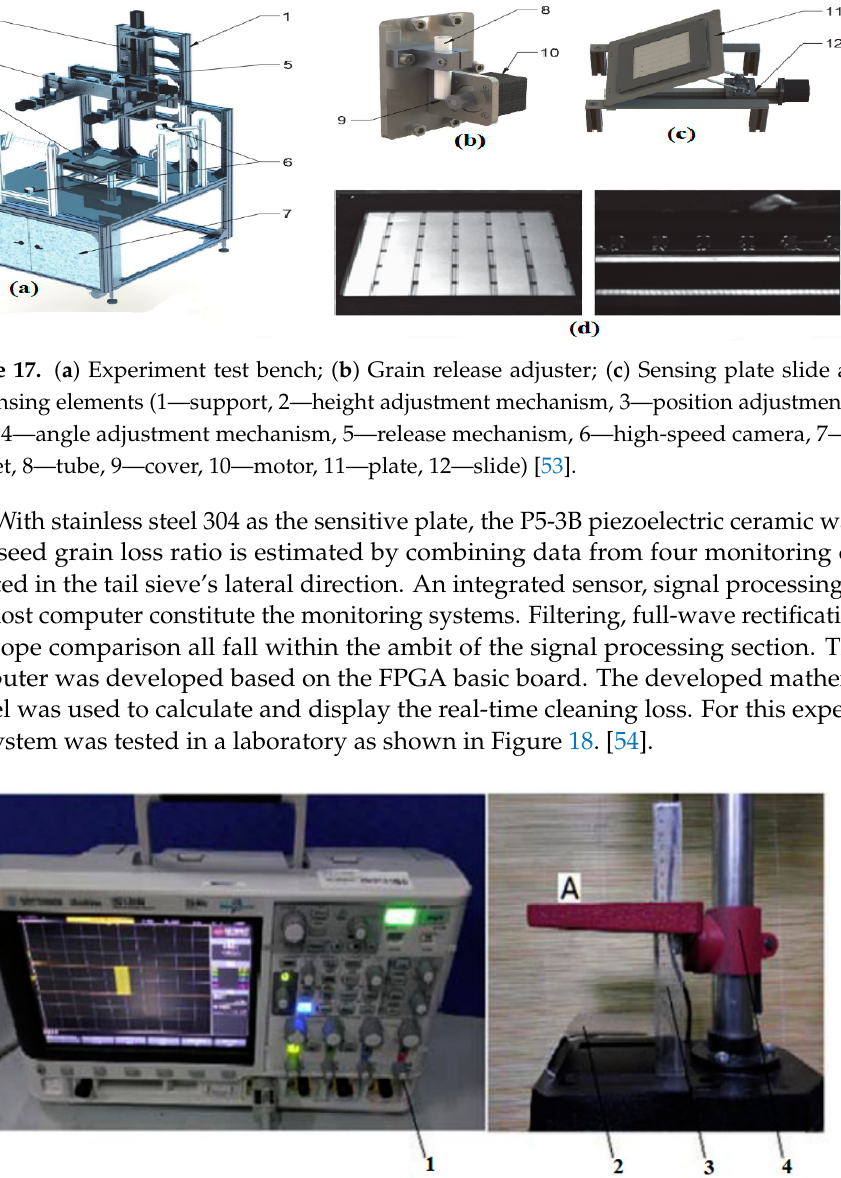
Figure 18. Grain impact experimental system: A—Grain release point, (1—oscilloscope, 2-sensor, 3—height gauge, 4—height adjuster)